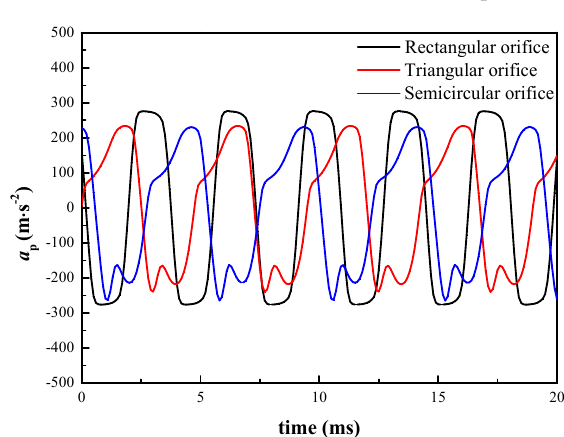
Figure 23. Accelerations of different orifice shapes.